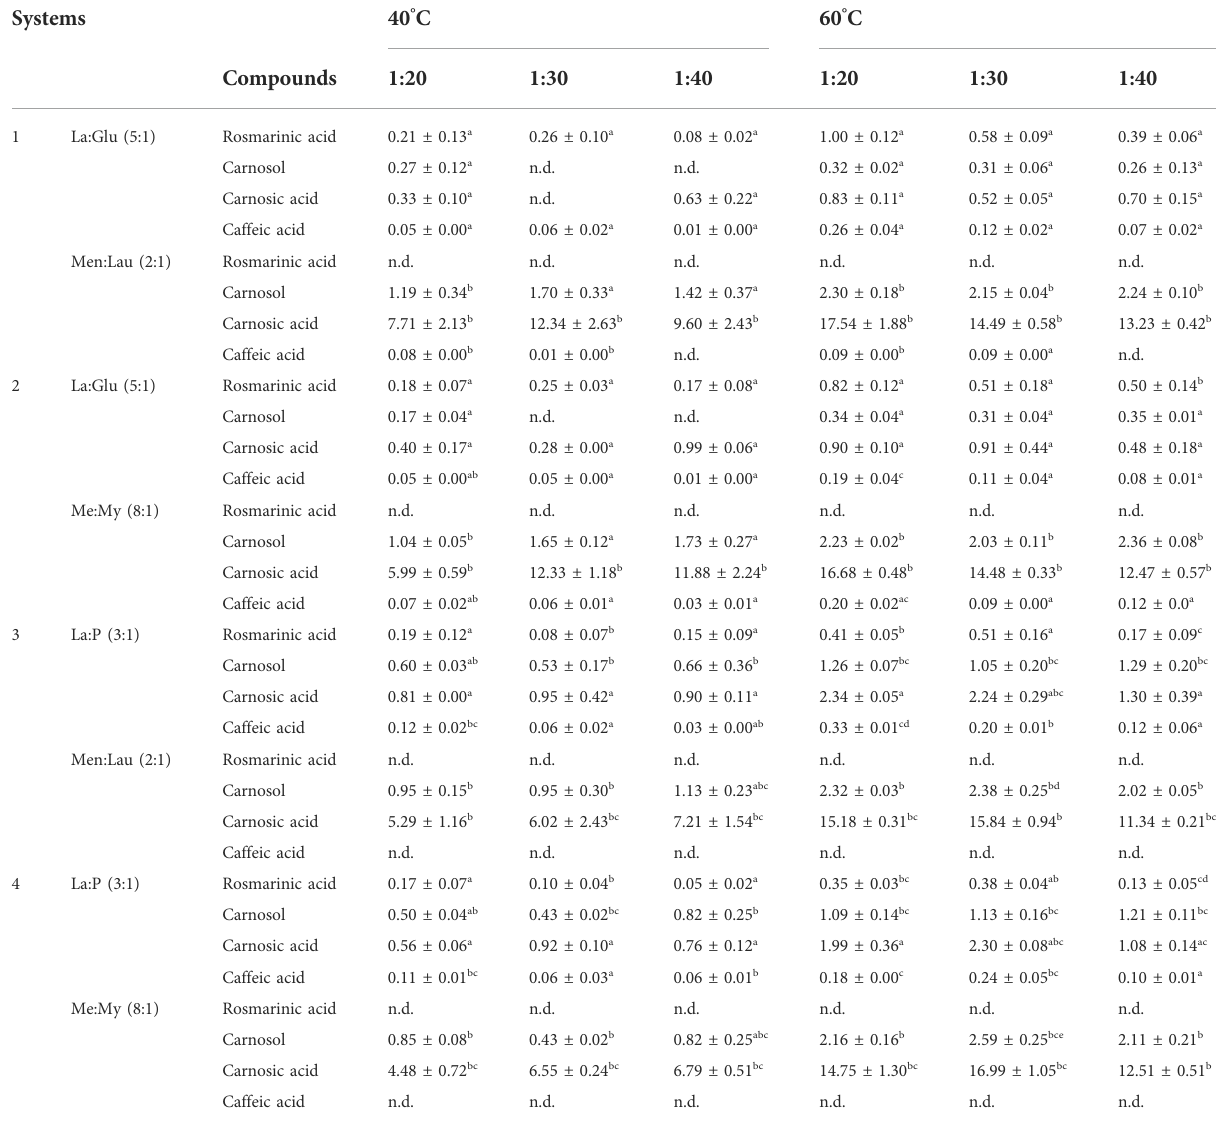
TABLE 6 Concentrations of rosmarinic acid, carnosol, carnosic acid, and caffeic acid (mg of compound/g rosemary) in the biphasic systems, varying the UAE S:L ratio (1:20, 1:30, and 1:40) and temperature (40 ° C and 60 ° C). Results are expressed as mean ± SD. Statistically signi fi cant differences between the ratios (1:20, 1:30, and 1:40) in each system for each compound are represented by letters. Different letters indicate signi fi cant differences within each system.